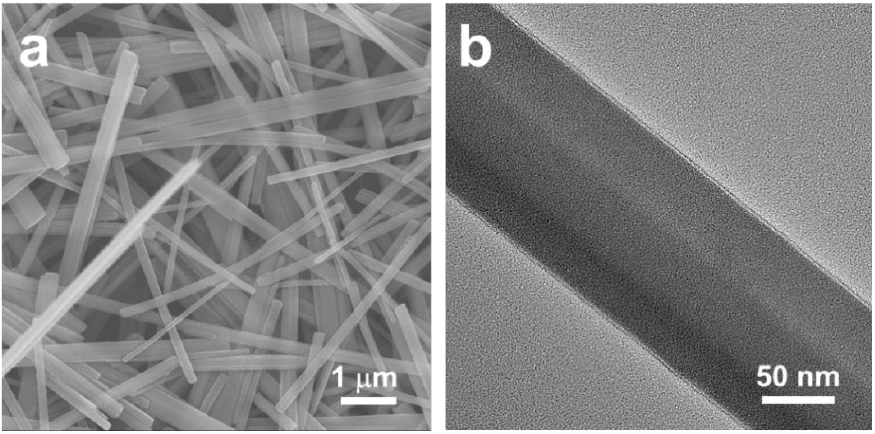
Figure 2. ( a ) Scanning electron microscopy (SEM) and ( b ) transmission electron microscopy (TEM) images of the FeS 2 –ethylenediamine precursor.